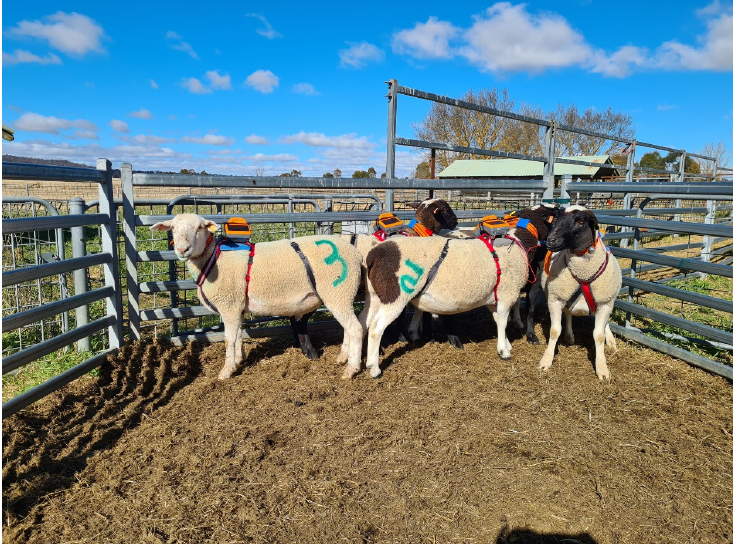
Figure 1. Gallagher eShepherd ® units fitted to the sheep using a modified dog harness including the wired collar around the neck containing the electrodes. The fit of each harness was checked to ensure normal movement by the animals and no obvious signs of discomfort resulting from the straps.